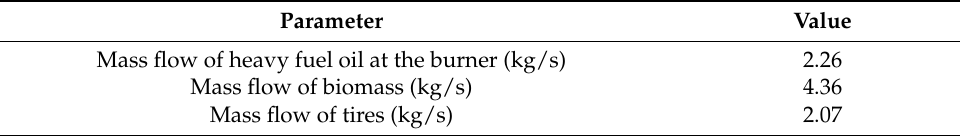
Table 8. Flows of fossil and alternative fuels used for partial